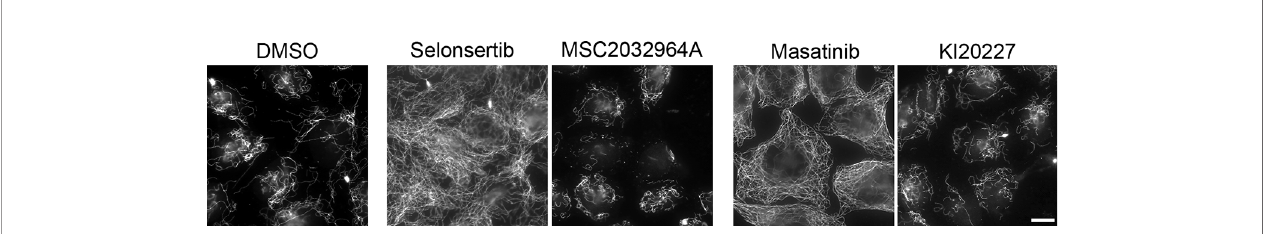
FIGURE 7 | Comparative analysis of the effect of structurally different inhibitors of ASK1 (Selonsertib and MSC203296A) and of tyrosine-kinase receptors (Masatinib and KI20227) on microtubule stability, as assessed by the resistance of the microtubule network to a CA4-induced depolymerization. HeLa cells were incubated for 90 min with 0.25% DMSO (control) or 10 µM of the indicated kinase inhibitors. CA4 (0.5 µM) was then added for 30 min. Cells were permeabilized and processed for immuno fl uorescence using the anti- a -tubulin antibody. Scale bar, 10